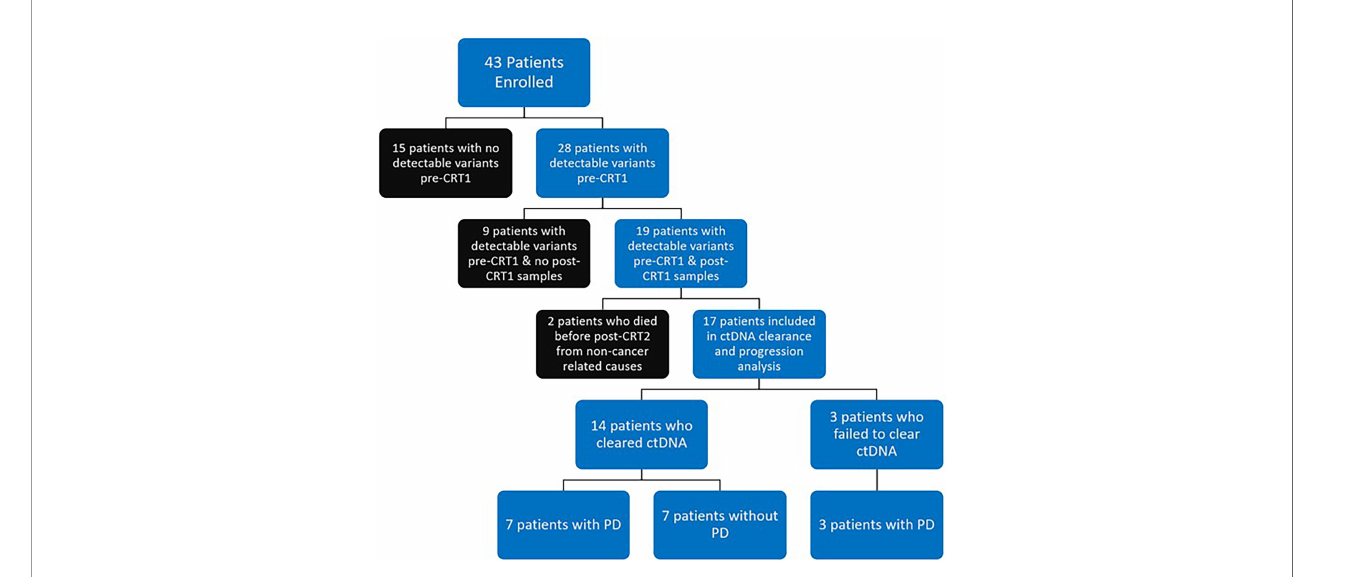
FIGURE 2 | Flow Diagram of Patient Disposition: 43 patients were prospectively enrolled. 28 of 43 patients (65%) had detectable variants at time of chemoradiotherapy (CRT) initiation (pre-CRT). 19 of 43 patients (44%) had detectable variants at pre-CRT and had samples collected at completion of CRT (post- CRT1) and were included in fi nal analysis. 2 of 19 patients (one who cleared ctDNA, one who did not) died from non-cancer related causes before the fi rst visit post completion of CRT (post-CRT2) and were excluded from analysis on clearance. Of the 17 patients who were included in analysis of ctDNA clearance and disease progression (PD), 14 (82%) had clearance of ctDNA, with 7 having PD and 7 remaining free from progression. All 3 patients who did not clear ctDNA had